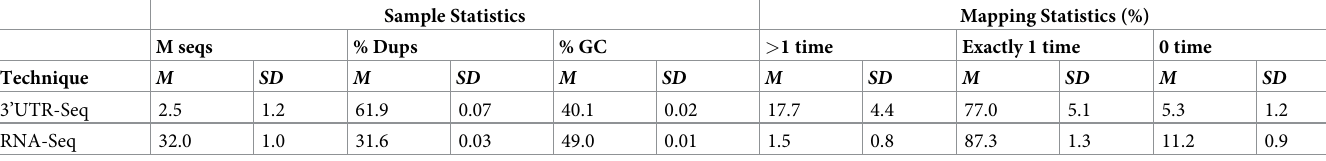
Table 1. Comparison of Sample and Mapping statistics of 3’UTR-seq and RNA-seq. Sample Statistics